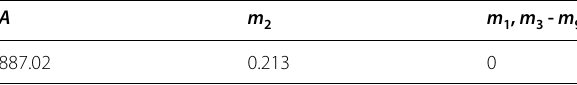
Table 3 Coefficient of Hansel‑Spittel equation in 34CrMo4 A